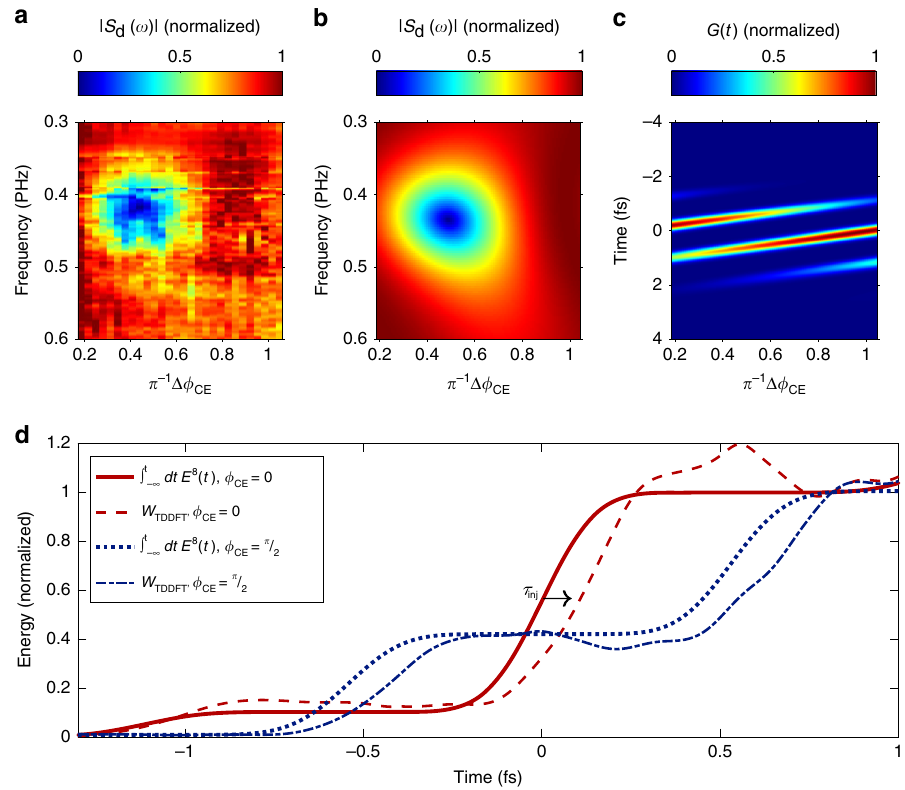
Fig. 3 Sub-cycle modulation of transition rate observed via phase-dependent spectral response. NPS waveforms were recorded over a series of values of ϕ CE of the injection pulse and converted to the frequency domain by taking the modulus of its Fourier transform. Normalizing each spectral component removes the in fl uence of the spectrum of E d ( t ) and shows the modulation depth of each frequency component. This normalized spectral response vs. phase a shows a strong, phase-dependent minimum at the 0.42 PHz central frequency of the injection pulse. This is consistent with a model simulation that uses E 8 ( t ) as the gating function ( b , c ). In this model, there is a single dominant photoinjection event for ϕ = 0, which results in a fl at, unmodulated spectral CE response. For ϕ CE = π /2, there are two transition events of comparable magnitude spaced by one half-cycle of the laser, as can be seen in the temporal evolution of the carrier injection rate ( c ). The interference between these two events makes a dip appear in the normalized spectral response ( b ) in the same region where the measured spectral response has the minimum. The ϕ CE -controlled photoinjection events cause an abrupt increase of the energy deposited in the system. In d , we compare a highly nonlinear component of the energy, calculated using TDDFT, to the time integral of E 8 ( t ). The TDDFT calculations show a slight time delay of the effective carrier injection, τ inj , relative to the maximum of the laser fi